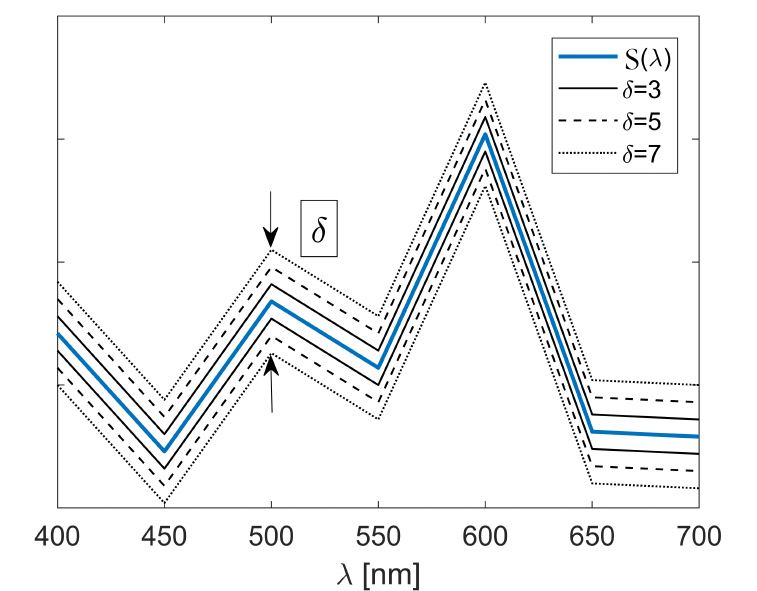
Figure 9. One pixel value (in blue) and the corresponding area between the δ -parallel covers (for δ =